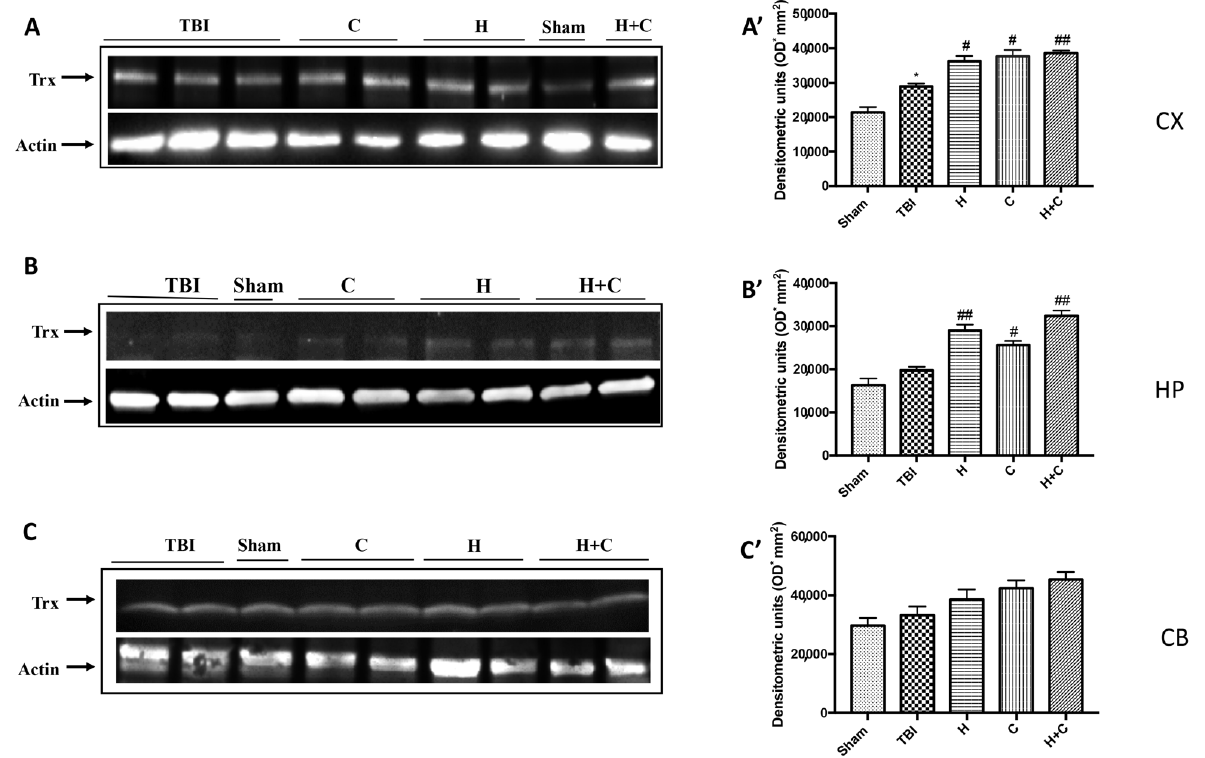
Figure 11. Effect of H. erinaceus or C. versicolor , or H. erinaceus + C. versicolor treatment on Trx protein after chronic TBI. Western blot analysis showed that the expression of Trx increased insignificantly in the TBI group in HP ( B ) and CB ( C ) regions and significantly in CX ( A ). H, C, and H + C treatment further significantly increased the expression of Trx in CX and HP regions but not in CB ( A – C ). The data are expressed as the mean SEM from n = 5 mice/group. Densitometry analysis: ( A’ ) * p < 0.05 vs. Sham; # p < 0.05 vs. TBI; # p < 0.05 vs. TBI; ## p < 0.01 vs. TBI; ( B’ ) ## p < 0.01 vs. TBI; # p < 0.05 vs. TBI; ## p < 0.01 vs. TBI; ( C’ ) not significant. 3.4. Effect of H. erinaceus or C. versicolor, or H. erinaceus Plus C. versicolor Treatment on Changes of PD Markers and on the Apoptotic Process after Chronic TBI To observe if chronic TBI can modify PD-like markers, brain sections from mice of each groups were stained with dopaminergic-specific markers (TH and DAT). The expres- sion of TH-positive neurons and DAT was notably decreased 30 days after TBI (Figures 12B (for TH) and 13B (for DAT), respectively, see densitometric analysis, F) compared to Sham group (Figures 12A (for TH) and 13A (for DAT), respectively, see densitometric analysis, F). Treatment with H or C or the combination increased the levels of these pro- teins. In particular, a greater efficacy of treatment with H + C was observed (Figure 12C– E (for TH) and Figure 13C–E (for DAT), respectively, see densitometric analysis, F).